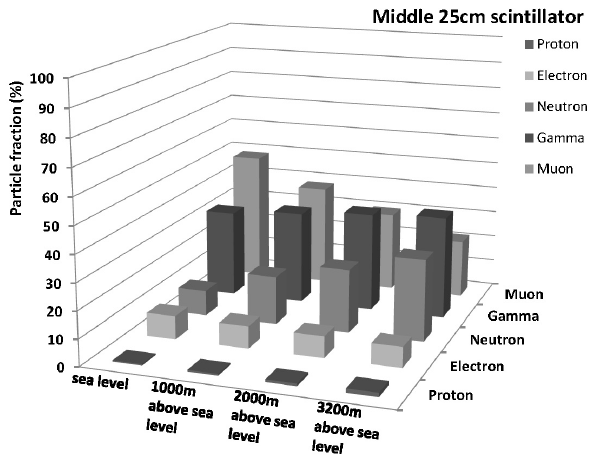
Fig. 5. Fractions of elementary particles detected by the middle layer of the SEVAN detector.